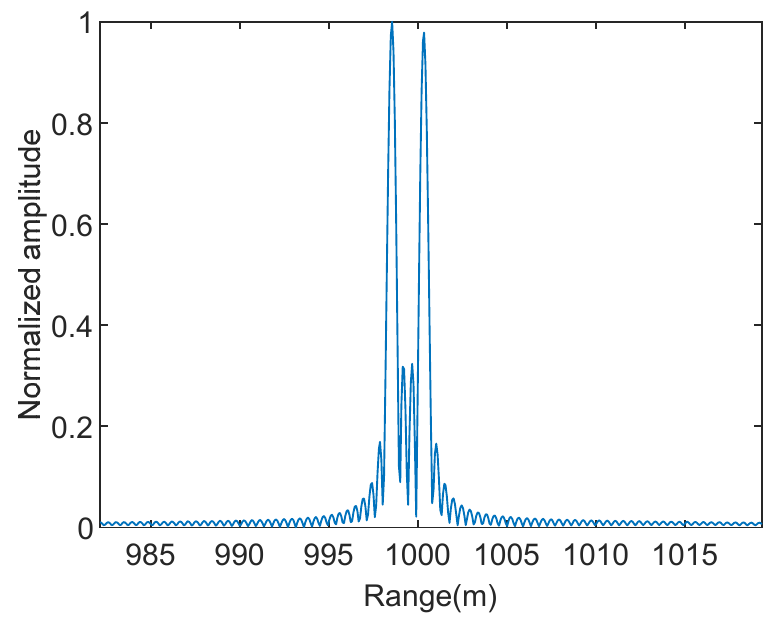
Figure 6. High-resolution 1D ranges of the two scatterers at cone top and bottom. The STFT is performed on S ( t m ) to obtain the slow-time-varying micro-Doppler frequency curves of the two scatterers, as shown in Figure 7a. The theoretical rotation radius of cone top and bottom are 0.3119 m and 0.593 m respectively, and the coning frequencies are both 6 Hz. The amplitude of the echo micro-Doppler frequency corresponding to the cone bottom scatterer is 72 Hz, which is greater than that corresponding to the cone top scatterer (i.e., 40 Hz). Through Equation (20), the theoretical micro-Doppler frequency curves can be drawn, as shown in Figure 7b. The amplitudes of theoretical micro-Doppler frequency curves are 74.66 Hz and 38.87 Hz respectively. It can be found that the echo micro-Doppler frequency curves are completely coincident with the theoretical one.